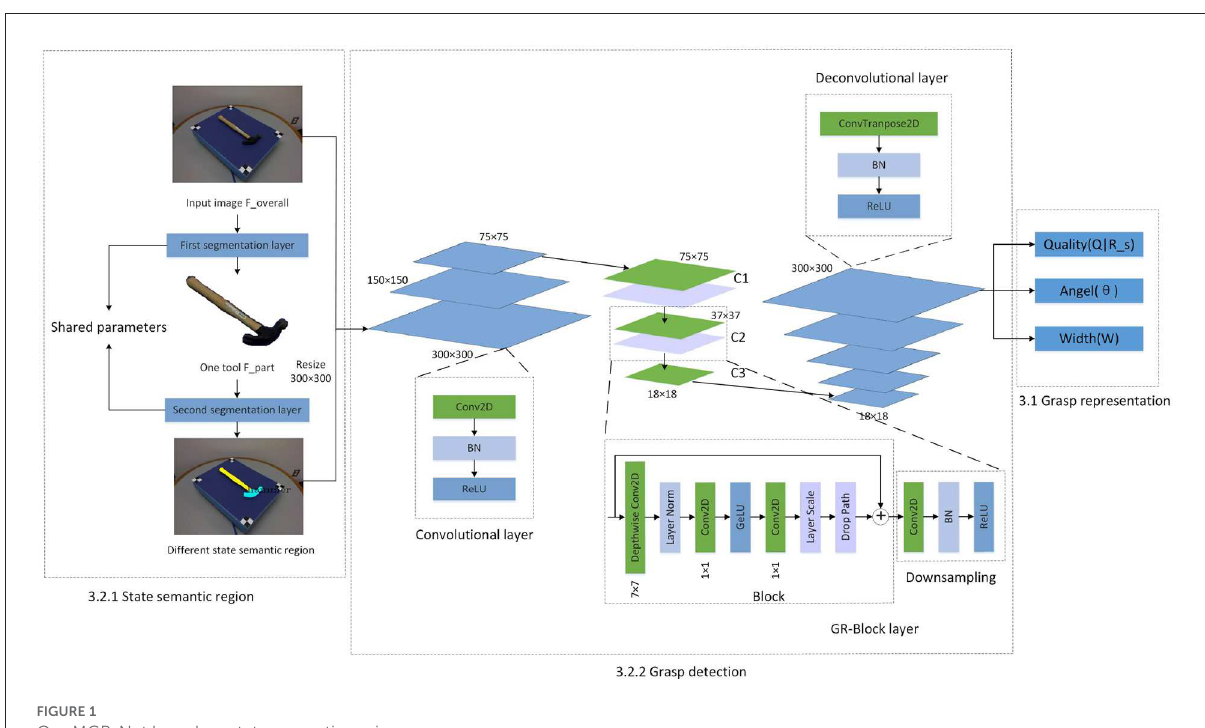
FIGURE1 Our MGR-Net based on state semantic